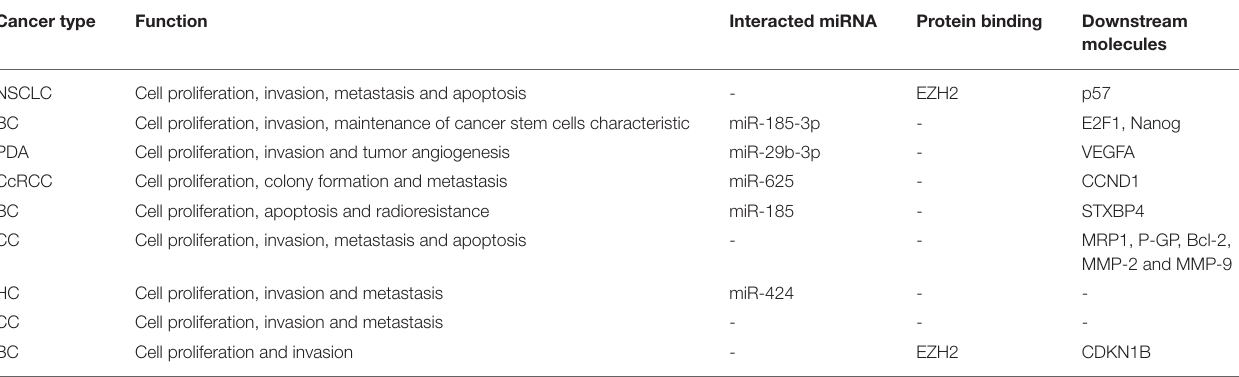
TABLE 3 | Functional characterizations and molecular mechanisms of LINC00511 in the included studies. Cancer